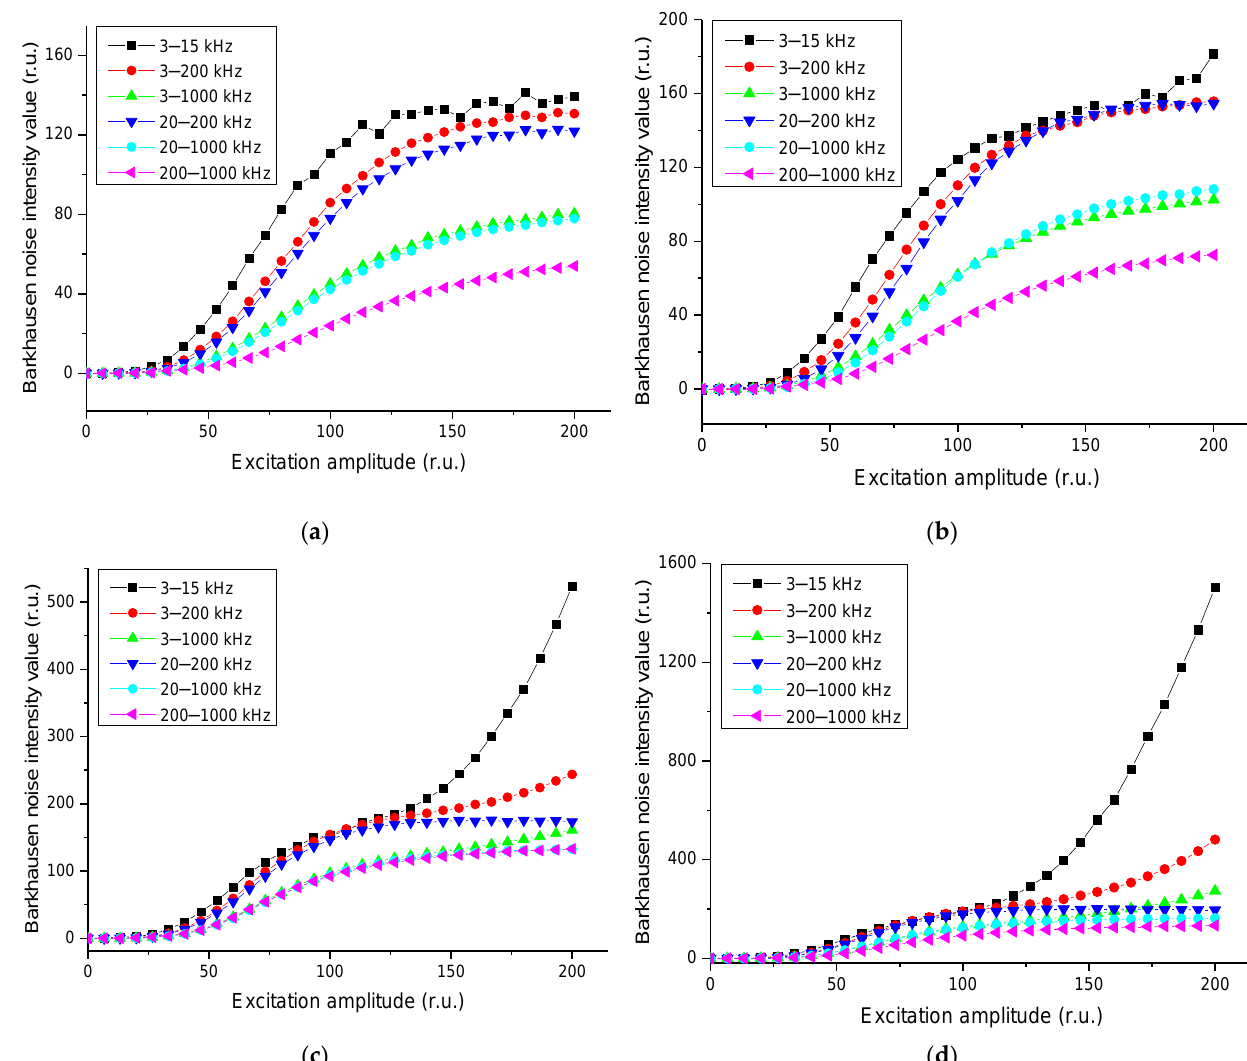
Figure 6. Measured magnetic Barkhausen noise intensity values for the indicated noise bands at magnetization frequencies of ( a ) 45 Hz, ( b ) 50 Hz, ( c ) 90 Hz, and ( d ) 120 Hz.